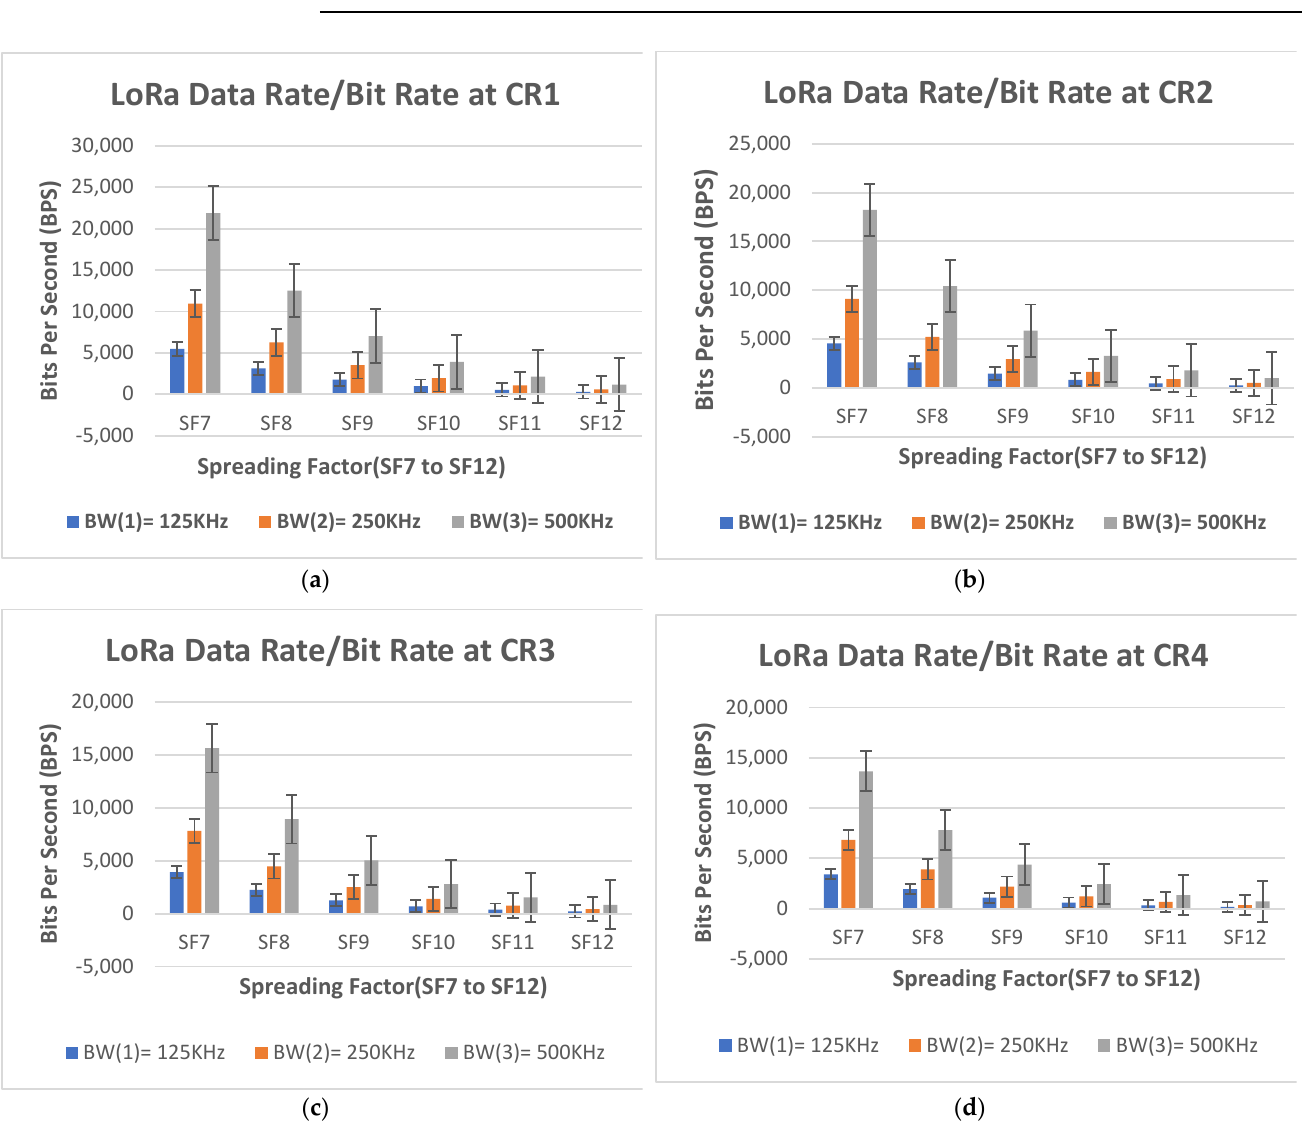
Figure 11. A bit rate of SF7-SF12 at CR1, CR2, CR3, CR4. ( a ) A bit rate of SF7-SF12 at CR1. ( b ) A bit rate of SF7-SF12 at CR2. ( c ) A bit rate of SF7-SF12 at CR3. ( d ) A bit rate of SF7-SF12 at CR4. (b) Receiver sensitivity: The input variables employed to determine the receiver ’ s long-range sensitivity are the BW, SF, and noise figure (NF). Equation (2) is used to obtain the results, and BW of 125 kHz, 250 kHz, and 500 kHz are also acknowledged. This BW is denoted by the follow- ing BW numbers: BW1 (125 kHz), BW2 (250 kHz), and BW3 (500 kHz) as shown in Table 9. For distinct SF, the signal-to-noise ratio (SNR) value varies. The SNR of −7 .5 for SF 7,